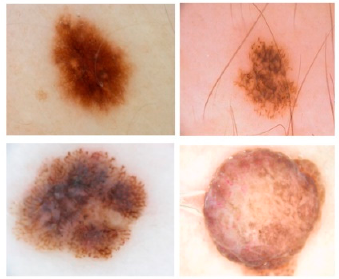
Figure 1. Sample dermoscopic images of skin lesions.